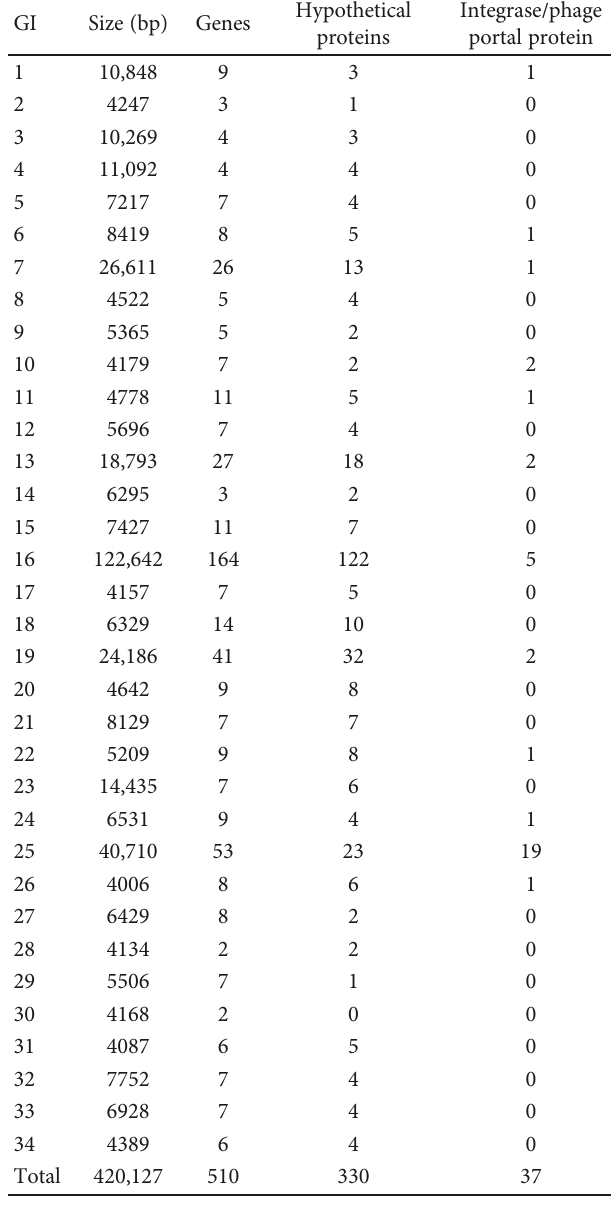
Table 4: Features of the gene islands found in the genome of B. subtilis